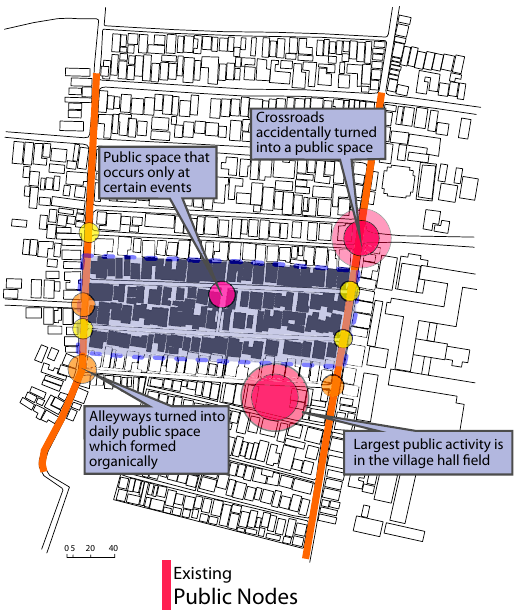
fig. 8. The layout of the public spaces are formed organically or deliberately in Kampung Karangrejo Sawah (created by the